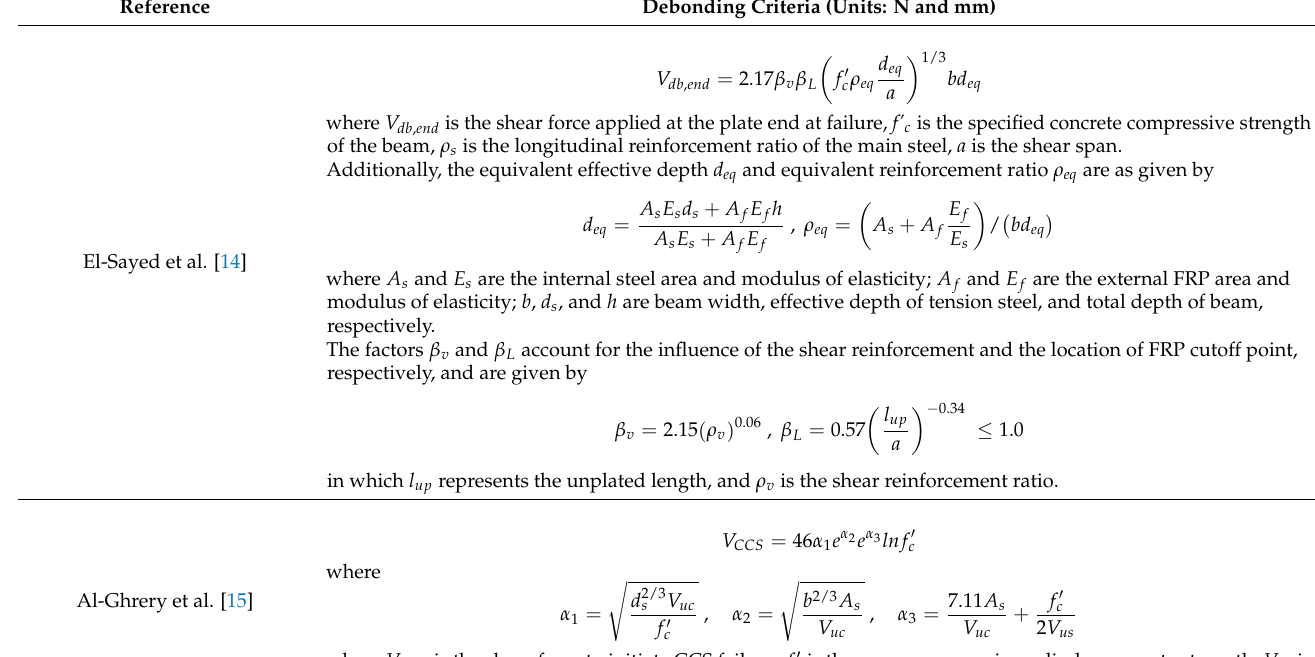
Table 4. Shear-based models for prediction of plate end